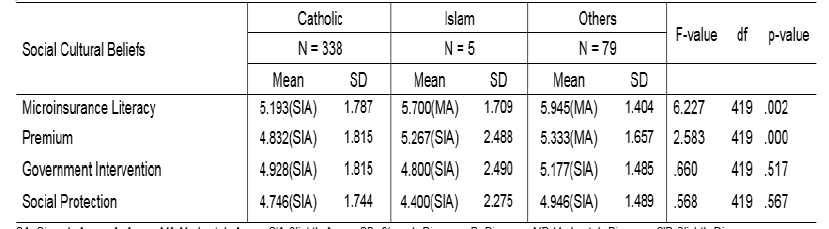
Table 12: Level of Agreement of the Respondents on the Dimensions of Microinsurance When Grouped According to Religion